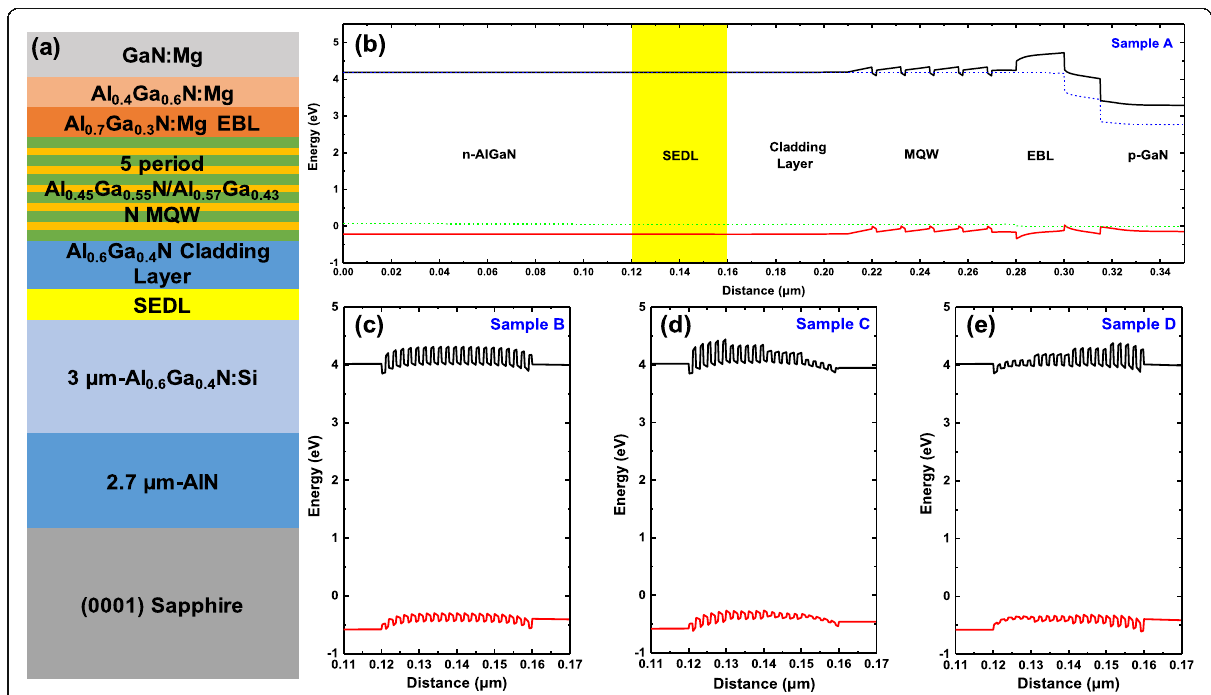
Fig. 1 Simulation of the designed structures of DUV LED with and without SEDL. a A schematic of DUV LED structure with chirped SEDL. The 20- period SEDL with different Al compositions is inserted between the n-type AlGaN layer and the AlGaN current spreading cladding layer. b Whole band structure of conventional sample ( a ) without SEDL. The highlighted area refers to the designate region where the SEDL is to be inserted. c Band structure of the SEDL of sample ( b ), which is the 20-period homogeneous Al0.5Ga0.5N/Al0.65Ga0.35N superlattice. Each layer of the SEDL is 1 nm. d Band structure of the SEDL of sample ( c ), which is four sets of the 5-period declining Al-content SEDL superlattice with different high-Al- content layers, namely 0.7, 0.65, 0.6, and 0.55. e Band structure of the SEDL of sample ( d ), which is four sets of the 5-period ascending Al-content SEDL superlattice with different high-Al-content layers, namely 0.55, 0.6, 0.65, and